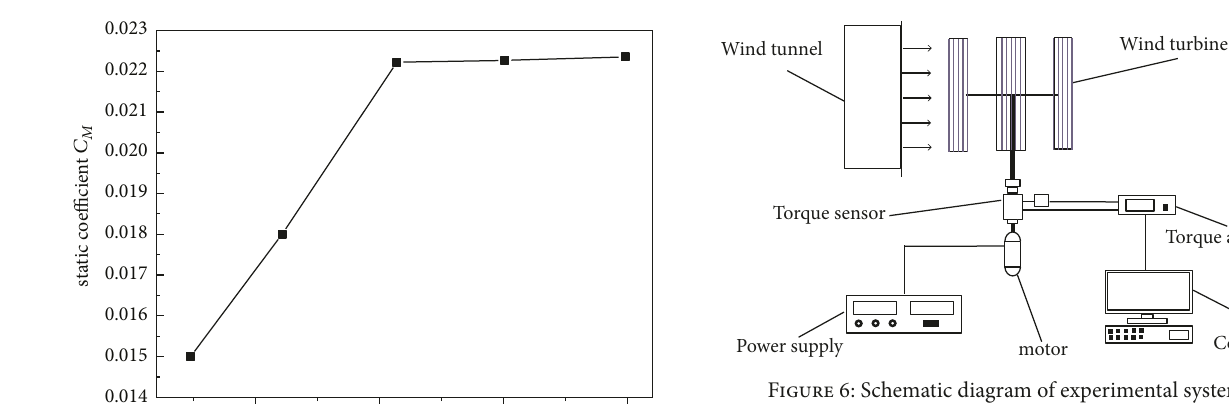
Figure 6: Schematic diagram of experimental